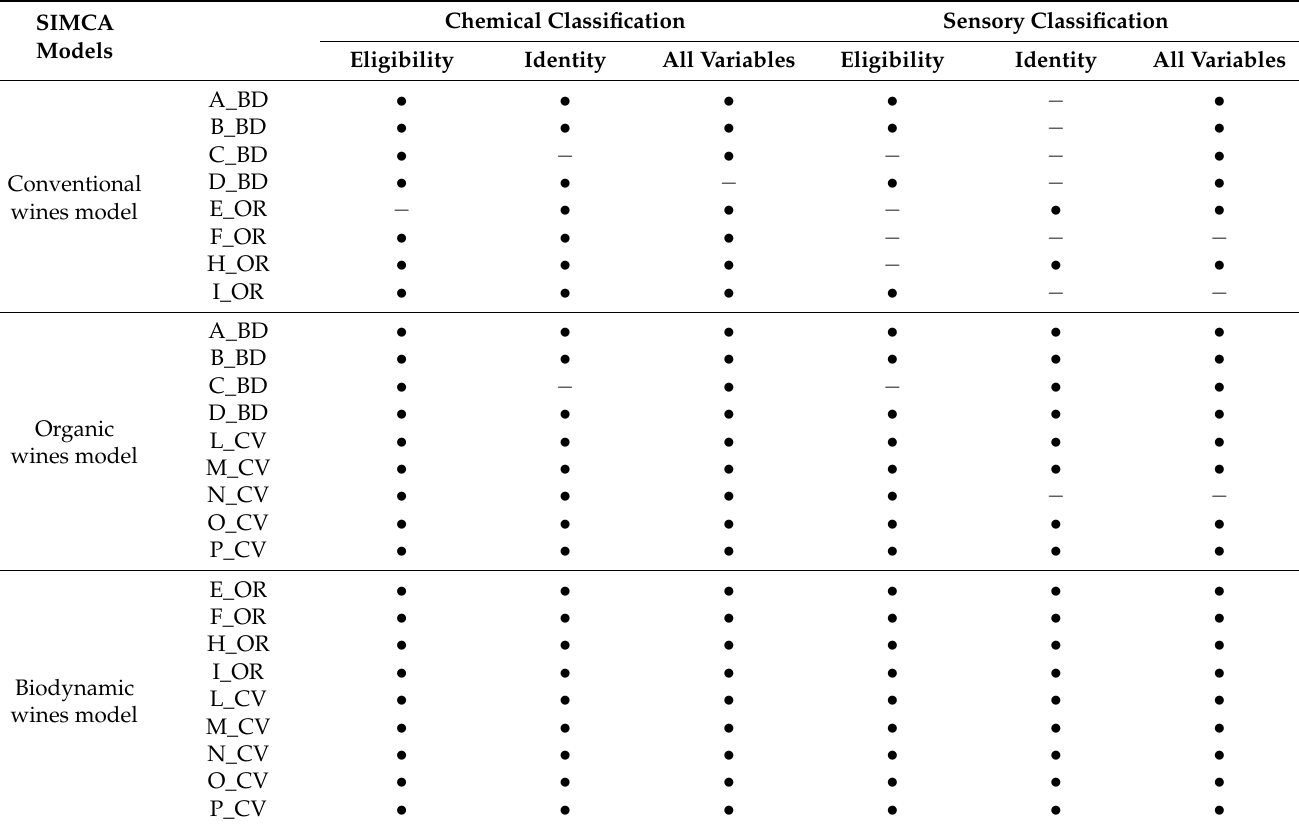
Table 5. Classification of the 2016 Chianti DOCG wines using SIMCA as a function of chemical and sensory variables (Eligibility, Identity, and All variables) for model development.